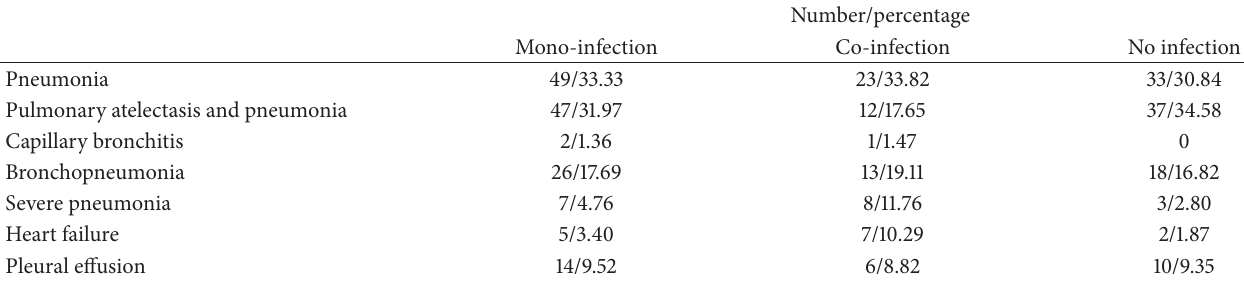
Table 4: Comparison between viral infection and clinical severity of